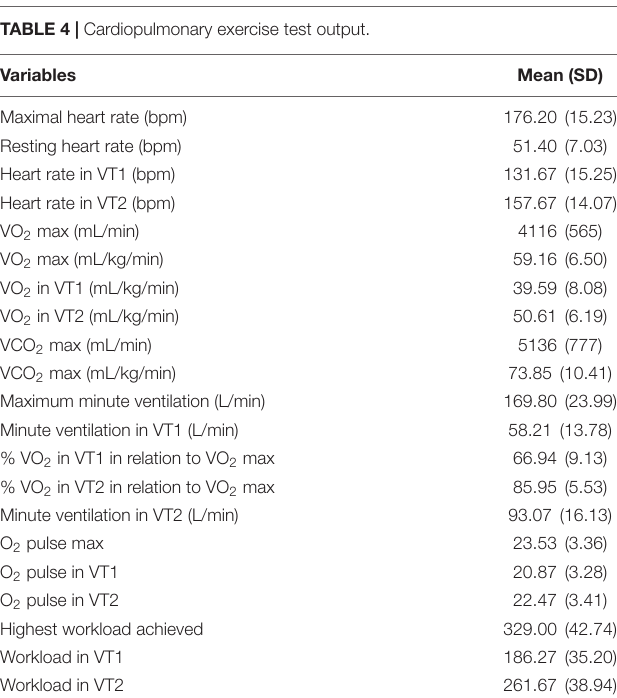
TABLE 4 | Cardiopulmonary exercise test